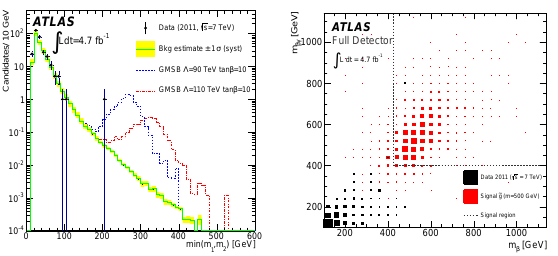
Figure 2. Observed data, background estimate and expected sig- nal in the two-candidate signal region in the slepton search (left) and in the full-detector R -hadron search (right). [1]